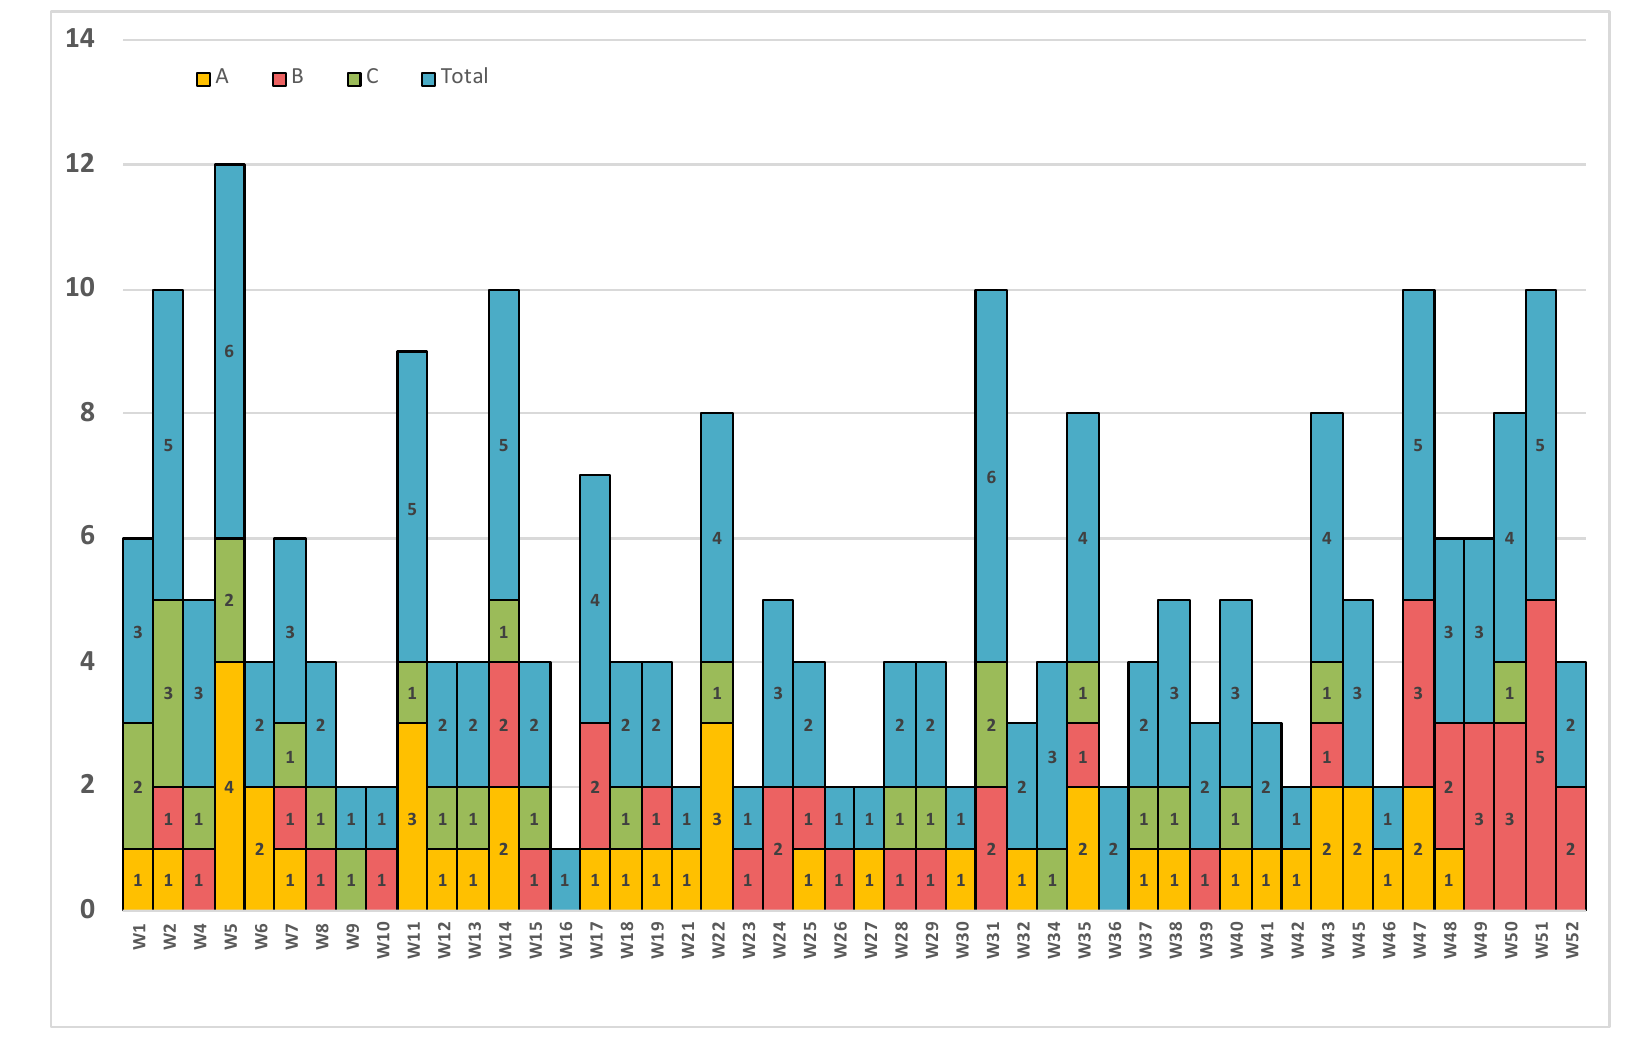
Figure 1. C. auris isolates by week over a 1 year period from (A) hospital A, (B) hospital B, (C) hospital C, and (Total) in all 7 hospitals. Numbers in the columns represent number of C.auris isolates per that